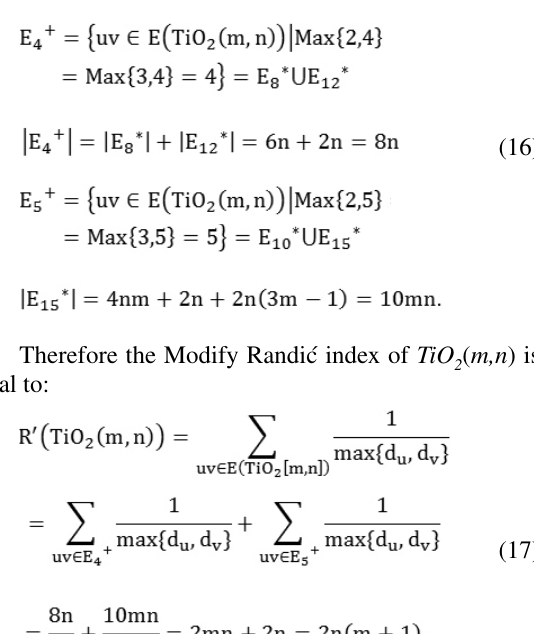
( m,n ) for m = 2,4 and 2